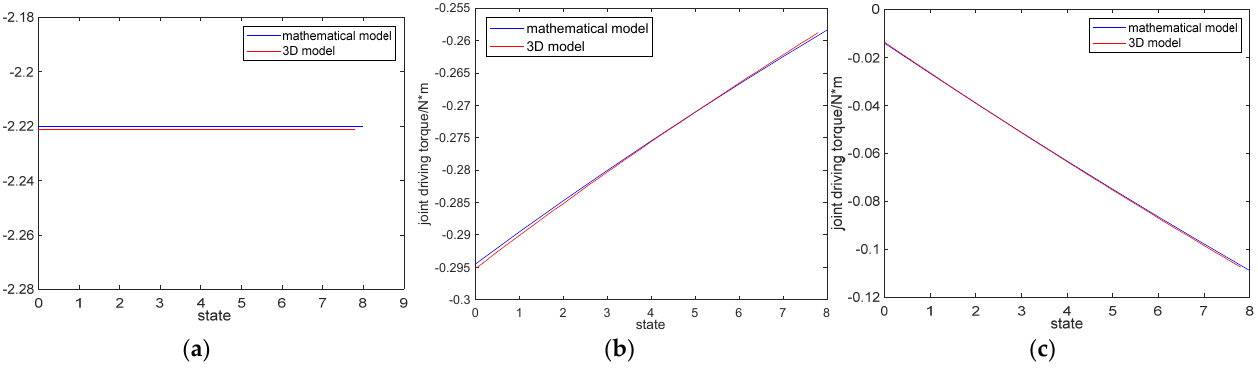
Figure 13. Comparison results of simulation 2. ( a ) Upper kinematic chain. ( b ) Bottom kinematic chain 1. ( c ) Bottom kinematic chain 2.